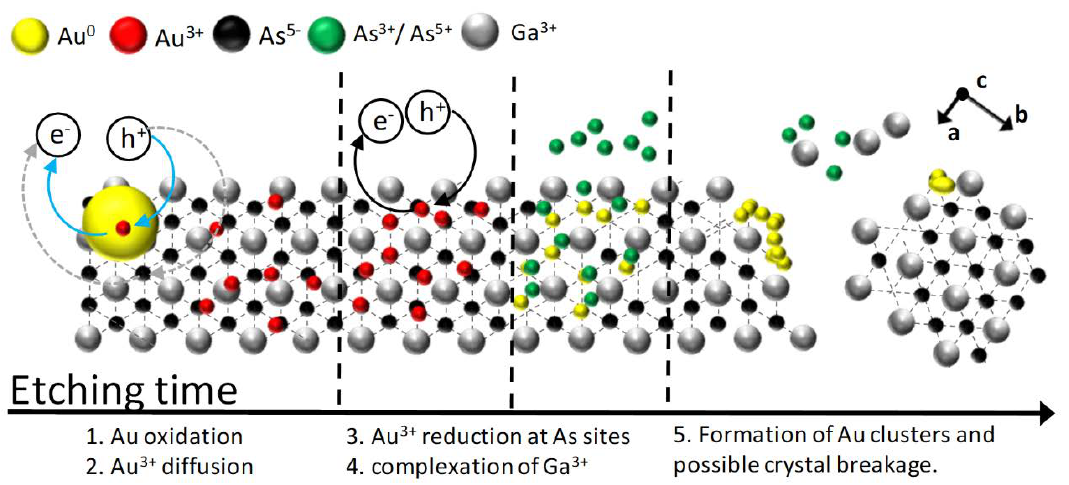
Figure 1. Schematic of the metal-assisted chemical etching (MacEtch) process of a GaAs (111)B